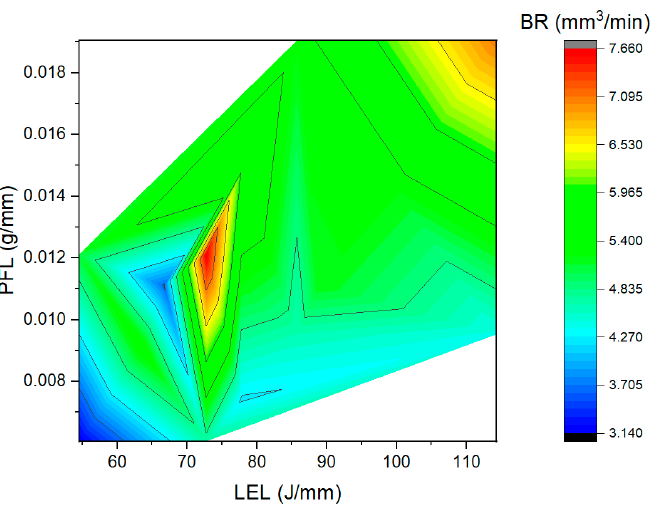
Figure 7. Effect of LEL and PFL on BR .